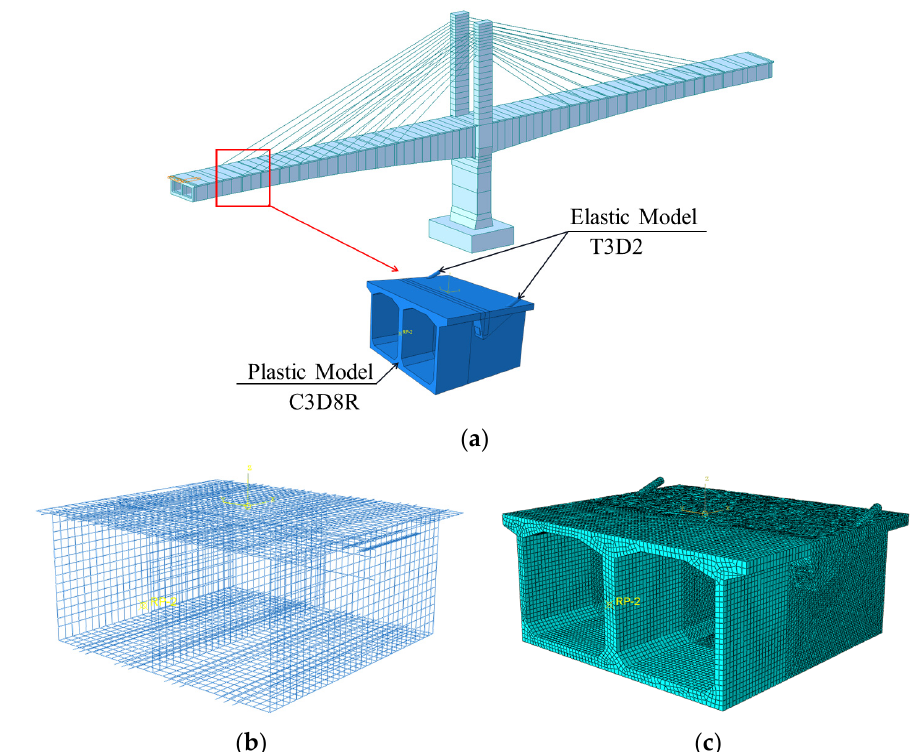
Figure 8. Diagram of the finite element model. ( a ) Finite element model; ( b ) model steel mesh; ( c ) local finite element model.